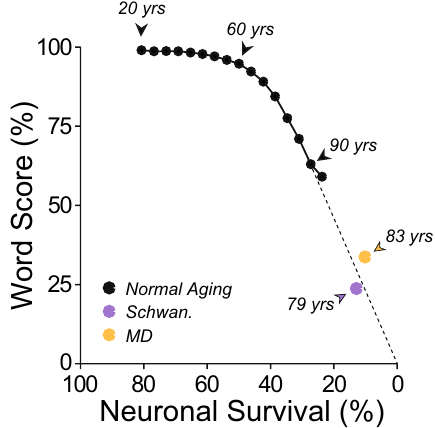
Figure 14. Prediction of word scores as a function of cochlear neural survival. Neuronal survival as a function of age was estimated from a best fit straight line to the data in Fig. 6A from a histopathological study of normal aging humans 3 . Word scores as a function of age were obtained from the present study (Fig. 6A). See text for further